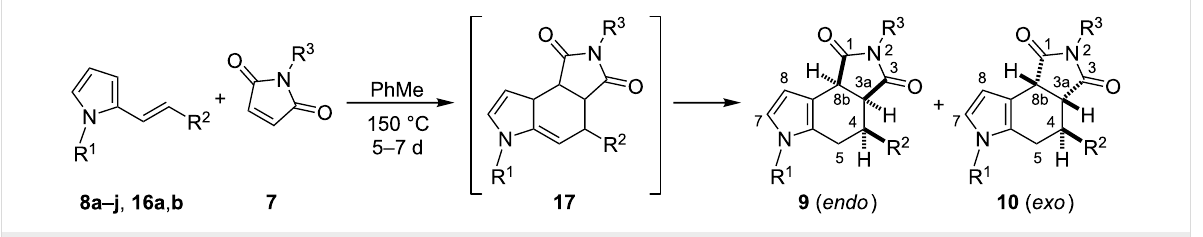
Scheme 3: Diels–Alder cycloadditions of pyrroles 8a – j and 16a – b with maleimides 7b – c